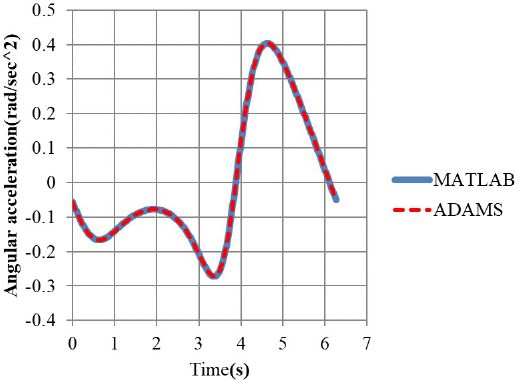
Figure 12. Comparison of our modeling computation with that of ADAMS on α 5 .